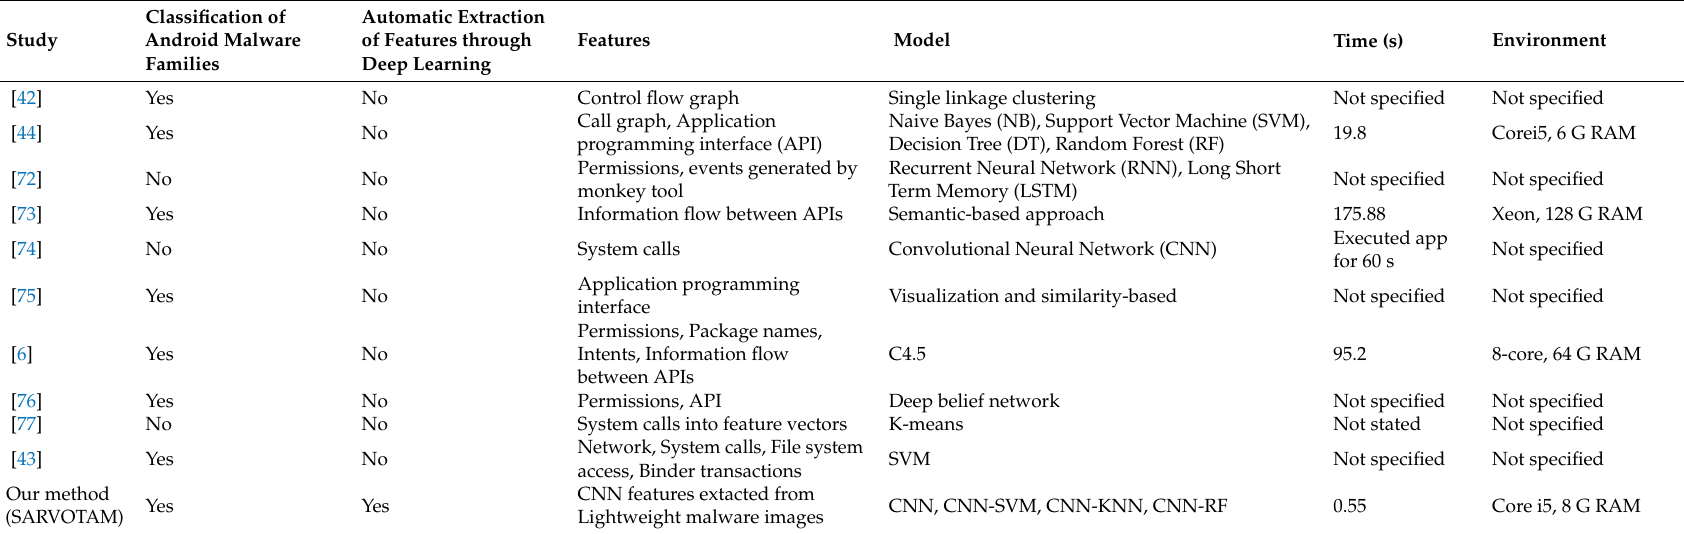
Table 5. Comparative summary of SARVOTAM with previous